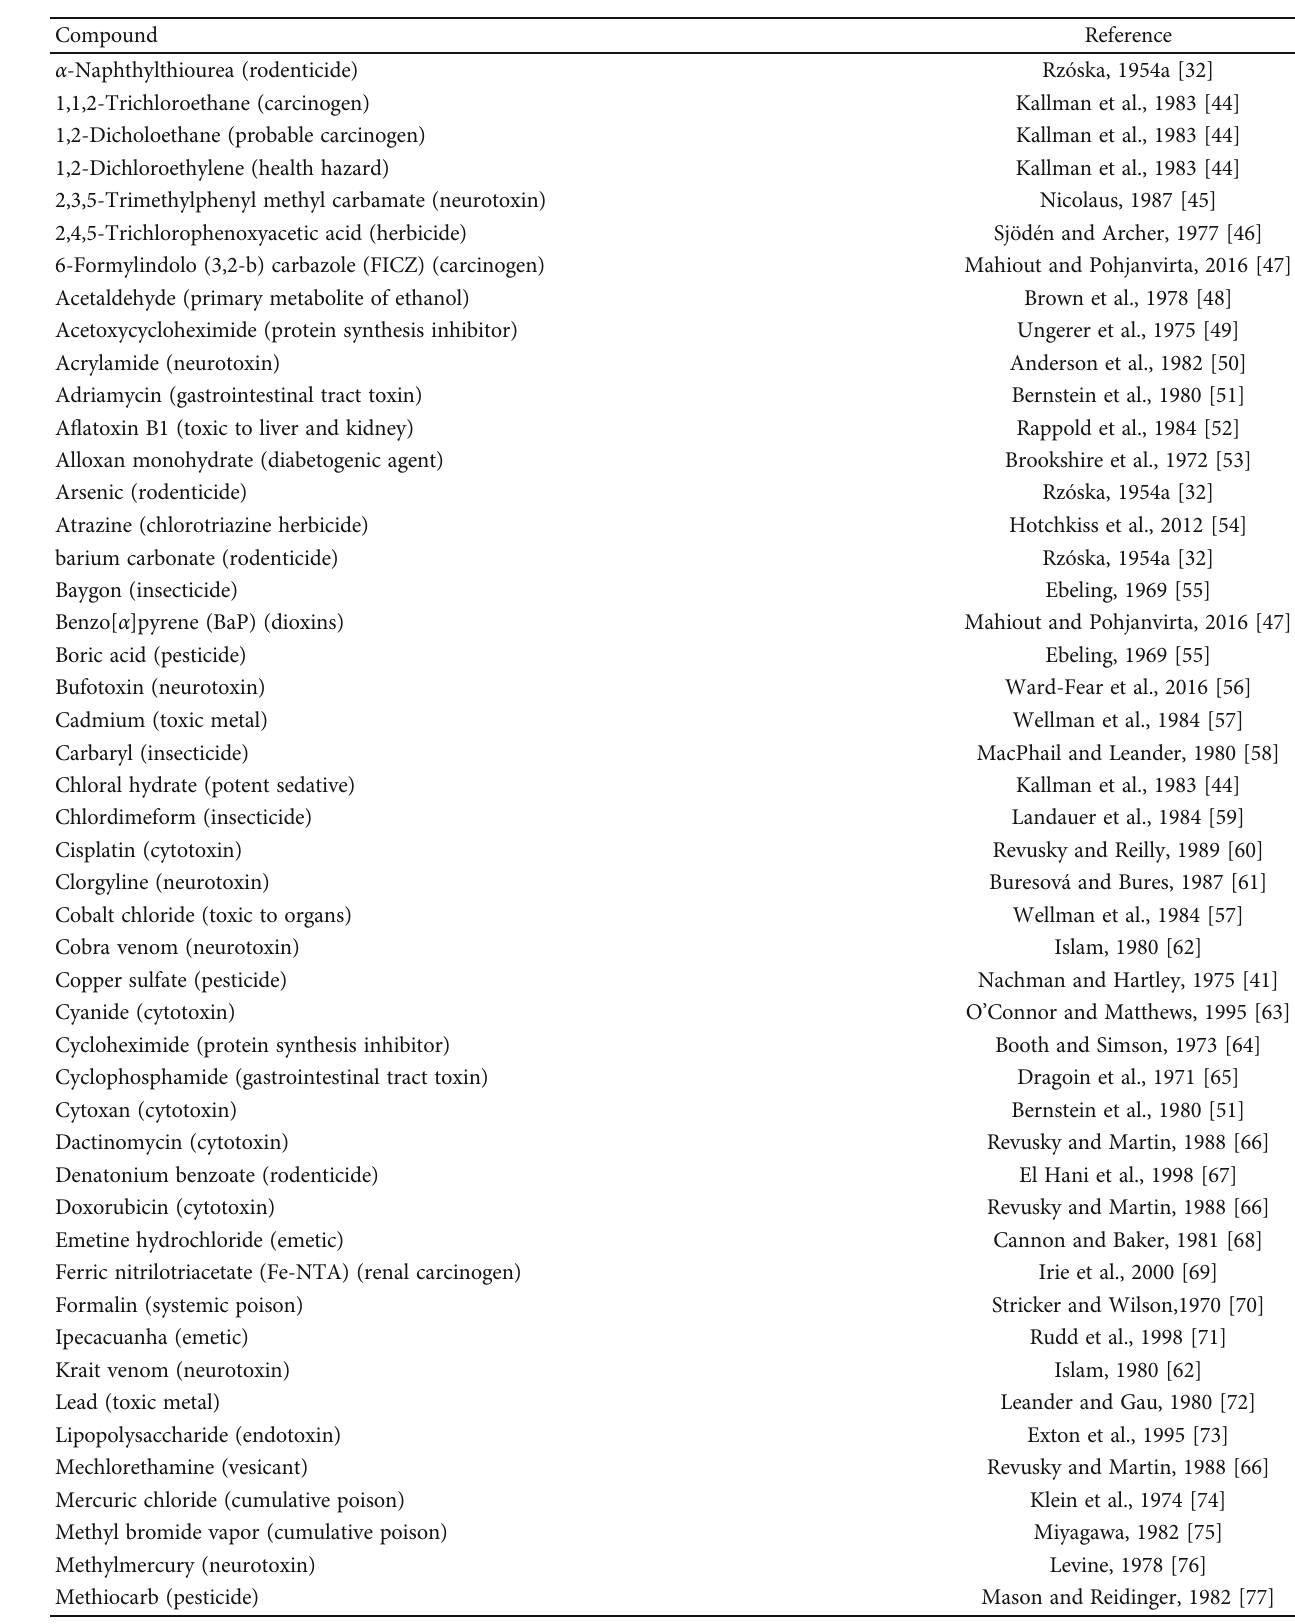
Table 1: Compounds with adverse or toxic e ff ects e ff ective in producing